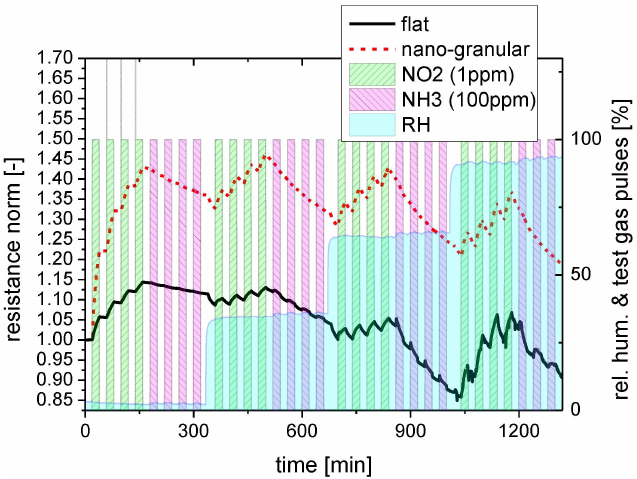
Figure 4. Response of SnO morphology towards NO